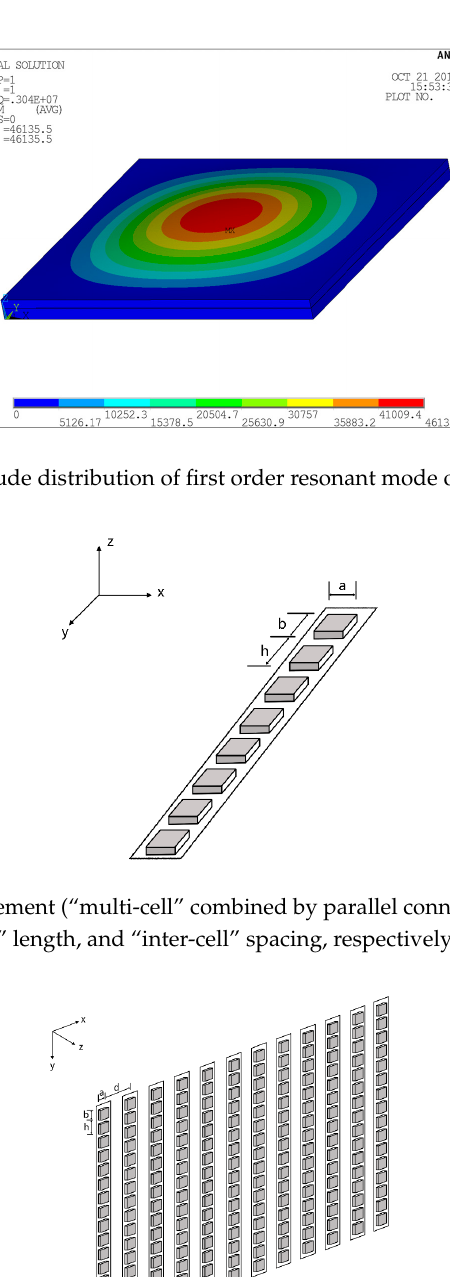
Figure 4. Schematic diagram of linear phased array. a , b , d and h represent element (“cell”) width, “cell” length, element width and “inter-cell” spacing, respectively.